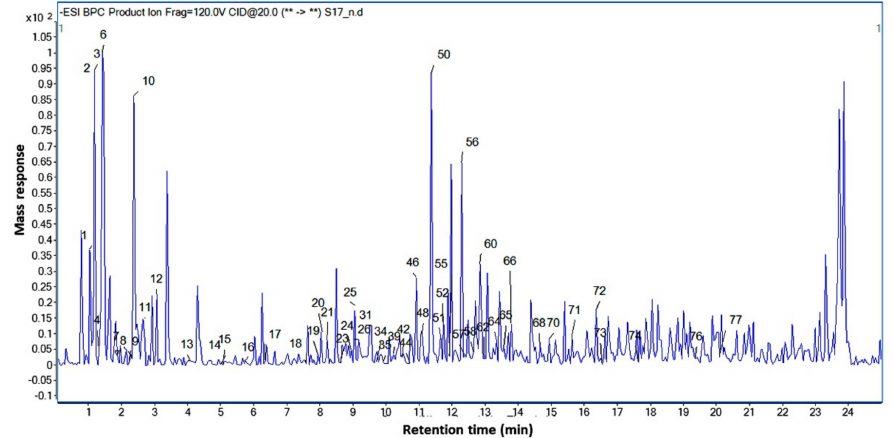
Figure 1. UPLC-qTOF-MS base peak chromatogram of C. conglomeratus alcoholic extract in negative ionization mode. Peak numbering follows that stated in Table 1.